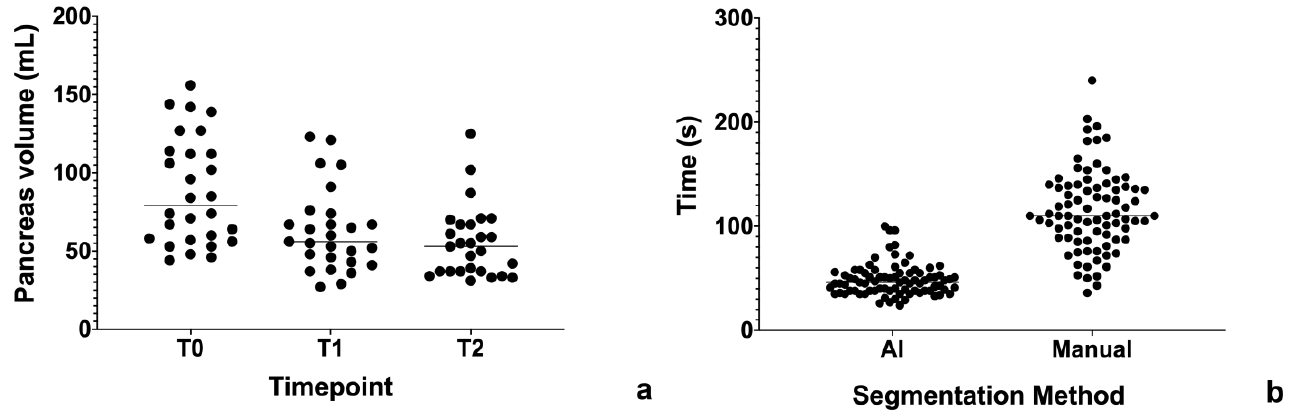
Figure 3. ( a ) Time required for pancreas segmentation. ( b ) Pancreas volume across timepoints (T0 vs. T1, p = 0.0034; T1 vs. T2, p = 0.2650; T0 vs. T2, p = 0.0001).